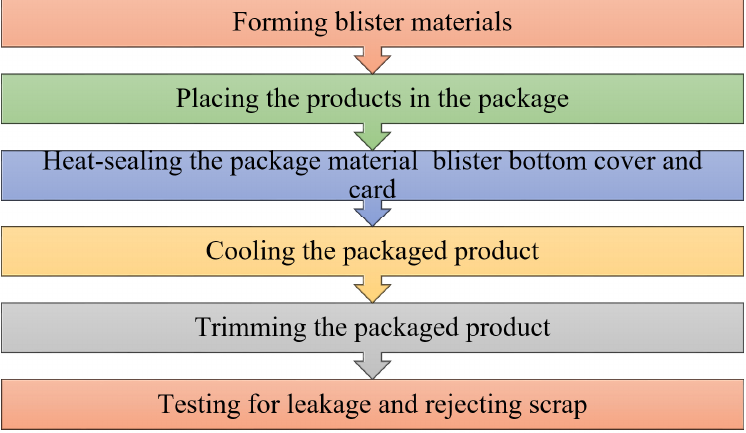
Figure 2. Procedure of blister packing machining process.